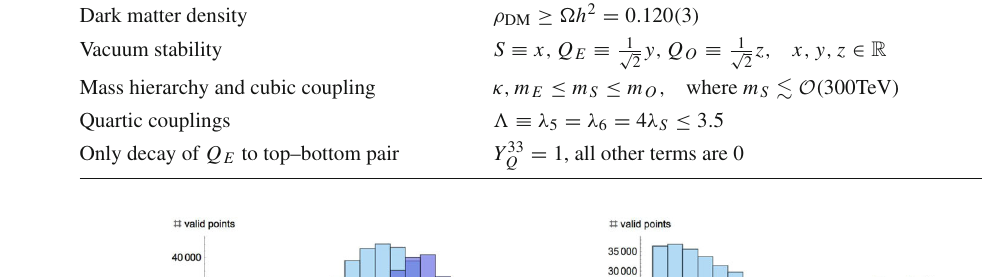
Table 1 Constraints on the allowed parameter space